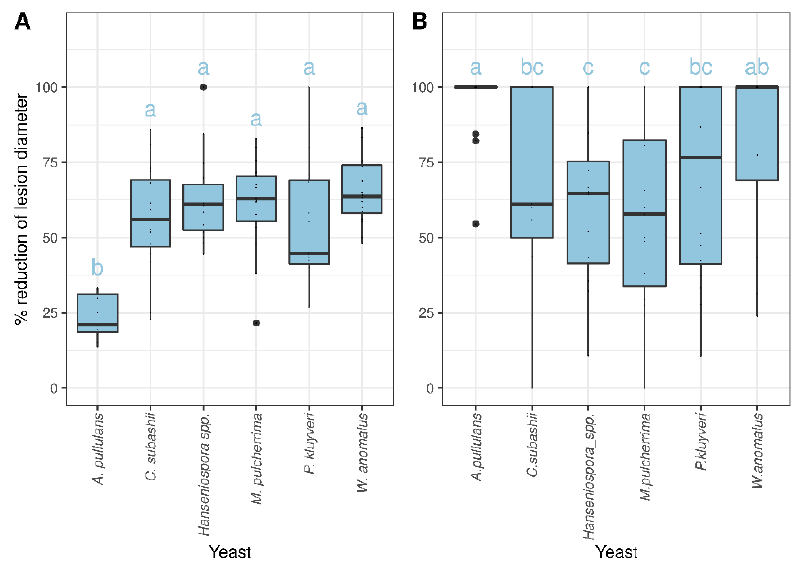
Figure 6. M. pulcherrima is able to suppress Neofabraea rot of apples. In situ competition assays against the apple storage pathogen Neofabraea vagabunda were performed with six strains of strongly antagonistic yeasts ( Aureobasidium pullulans , Candida subhashii , Hanseniaspora sp., M. pulcherrima , Wickerhamomyces anomalus , and Pichia kluyveri ). The pathogen was added 3 h ( A ) or 24 h ( B ) after the yeasts were added to artificial lesions. For each yeast, the reduction of the Neofabraea lesion diameter was determined in 10 apples. The whole experiment was performed twice. Letters indicate statistical significance determined by one-way ANOVA with Tukey ’ s multiple comparisons test and Benjamini – Hochberg correction ( p < 0.05).